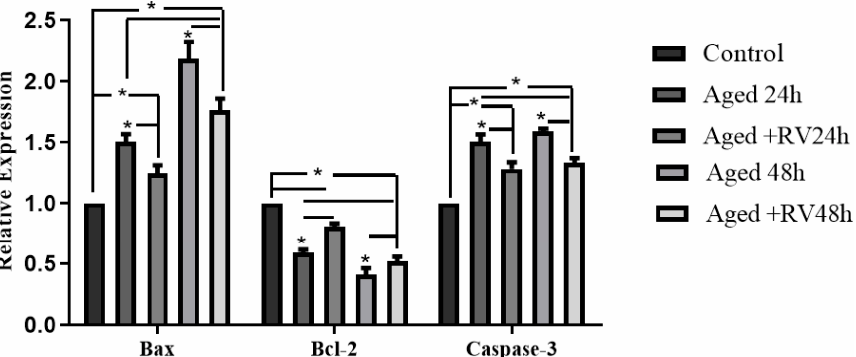
Figure 3. The relative mRNA expression of apoptosis related (Caspase-3, Bcl-2, and Bax) genes in aged porcine oocytes at different time periods. Significant difference (* p < 0.05).